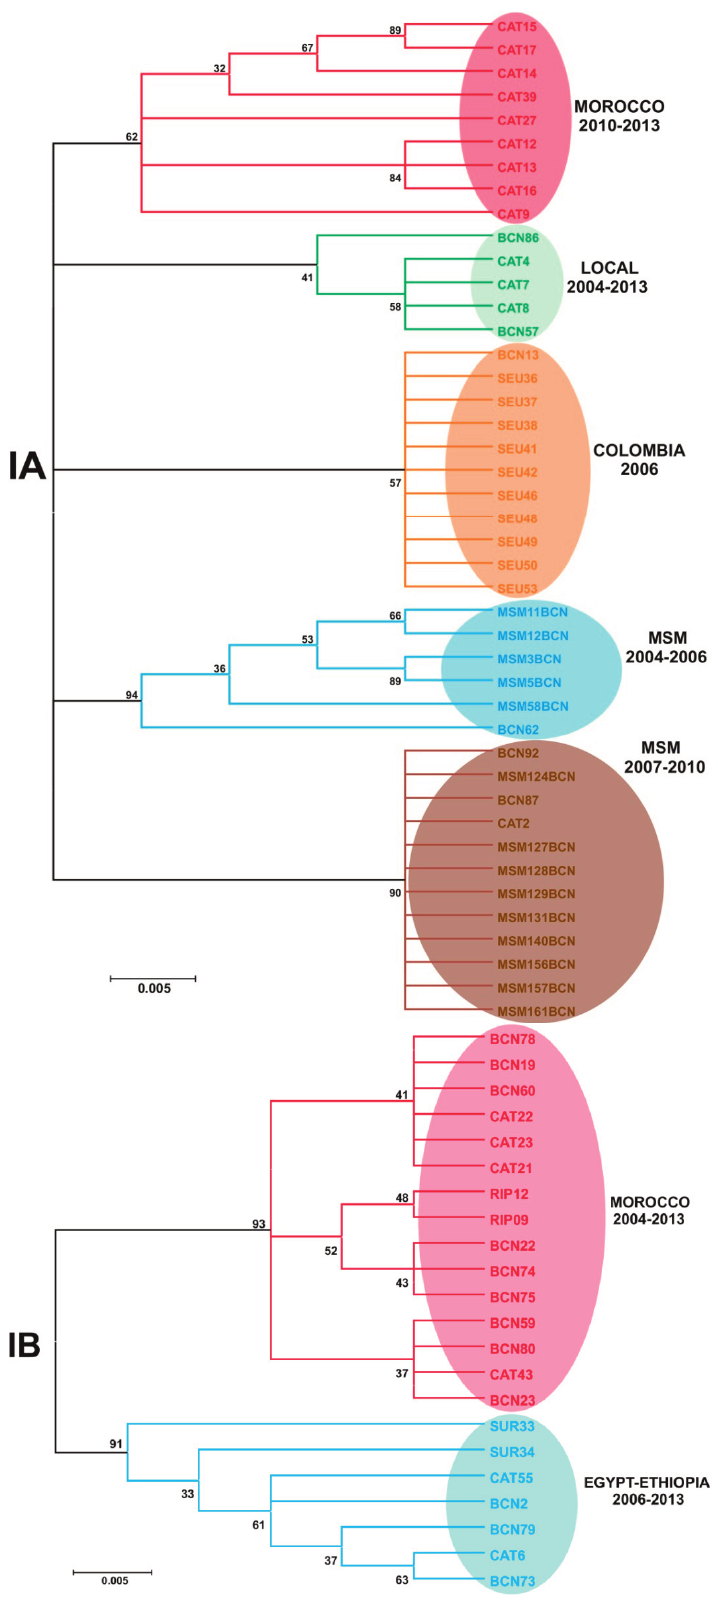
Figure 6. Phylogenetic trees based on the VP1/2A junction region, from strains belonging to subgenotype IA and IB. Neighbor-Joining, Kimura 2-parameter, bootstrap 1000